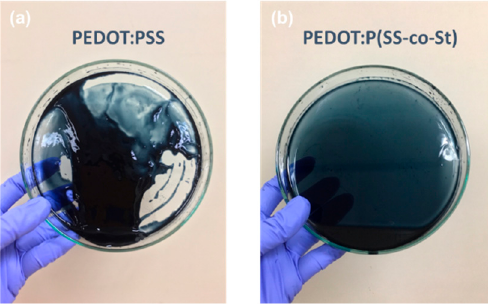
Figure 4. Solution-stability comparison of ( a ) pristine PEDOT:PSS and ( b ) PEDOT:P(SS-co-St).